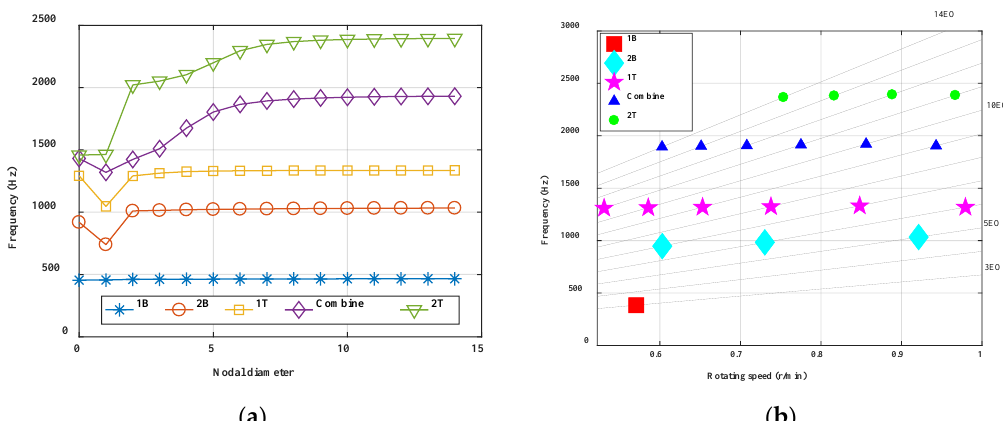
Figure 14. Natural vibration characteristics for the blisk: ( a ) Frequency on ND at cruise rotating speed; ( b ) Campbell diagram.